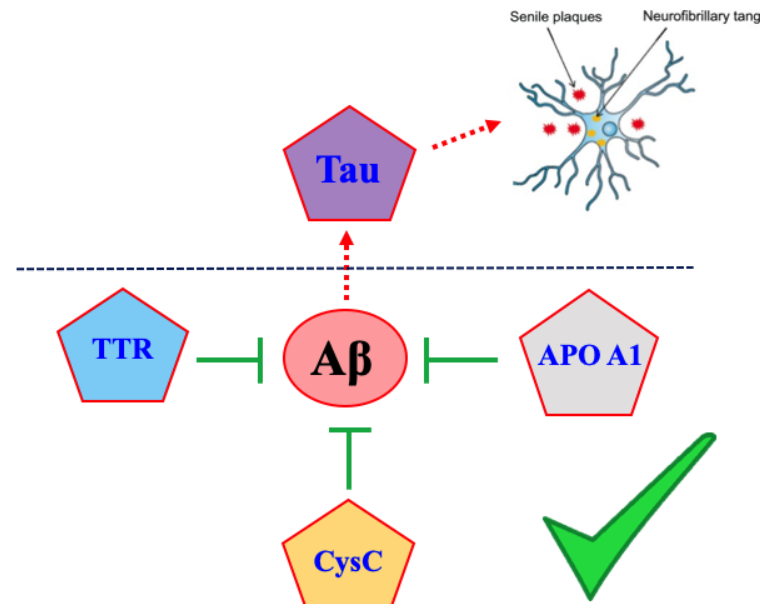
Figure 1. A cross-amyloid network between Aβ peptide and four amyloidogenic proteins. Proteins with intrinsic amyloidogenic potential are contoured by red lines. Green symbols: amyloid proteins that have a positive effect against the progression of AD. Red dashes arrow: amyloid protein pathway according to the amyloid cascade hypothesis. The details of the interactions are discussed in the review for each protein .